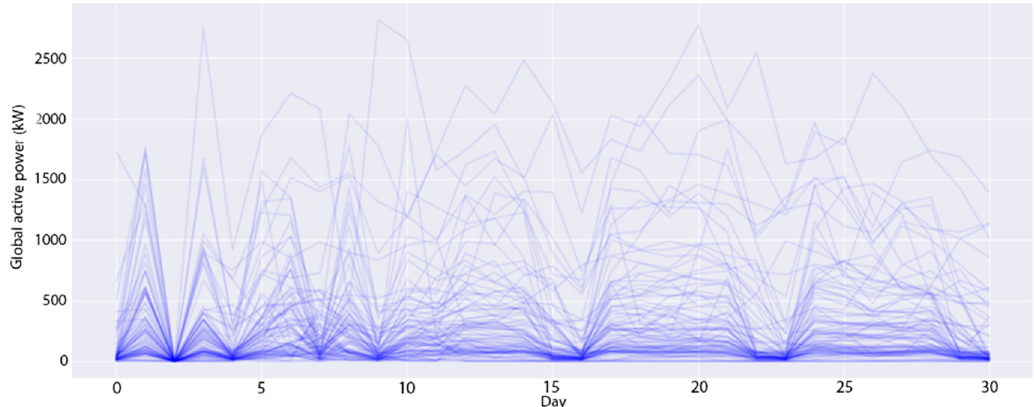
Figure 5. All the daily-load profiles in 30 days of the B2 dataset.